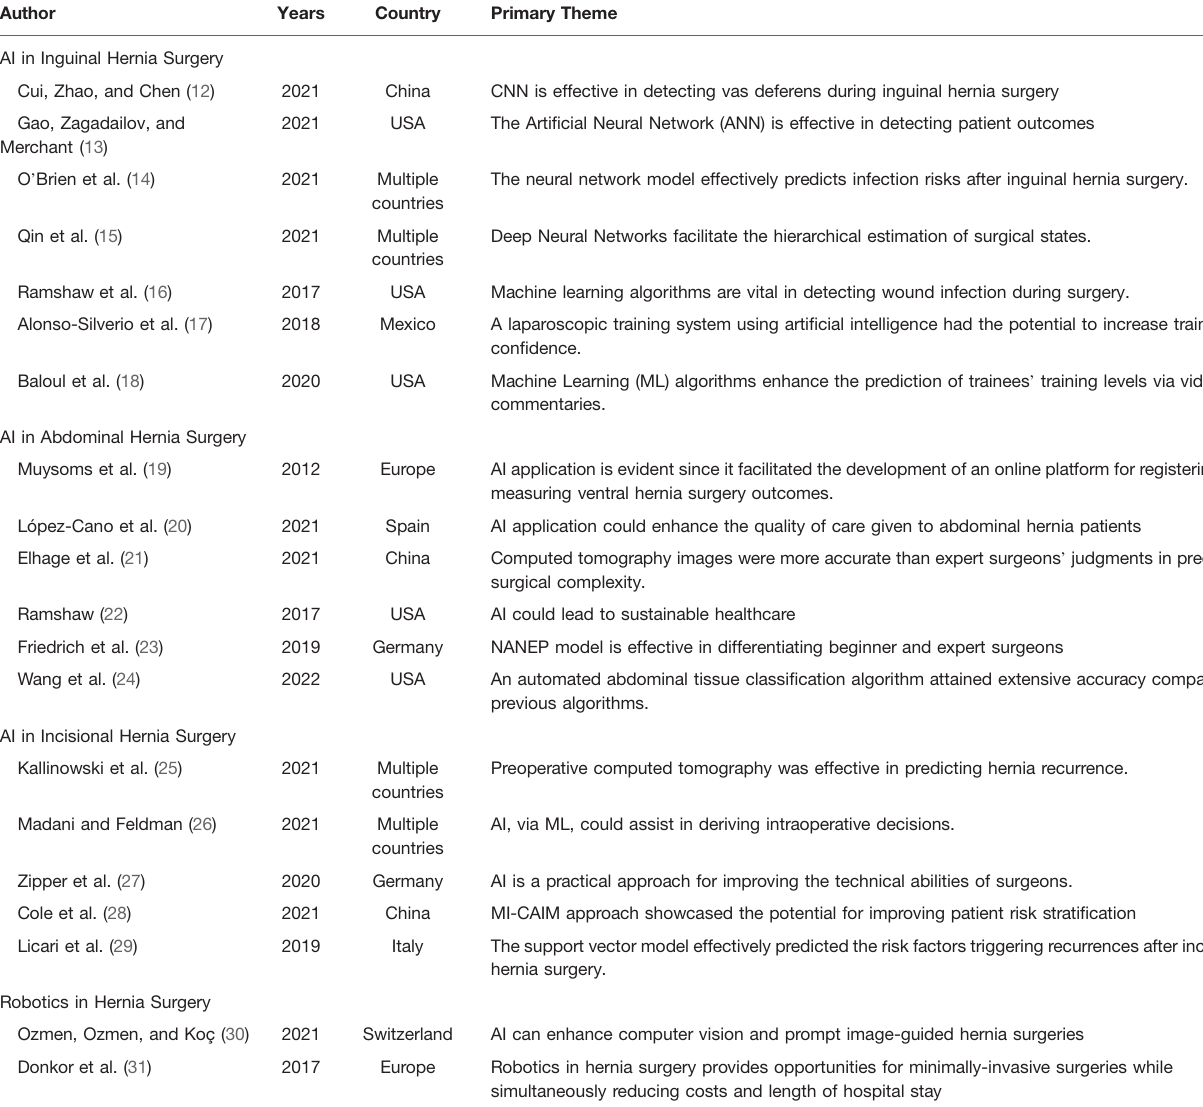
TABLE 1 | Main themes of included studies and characteristics of included